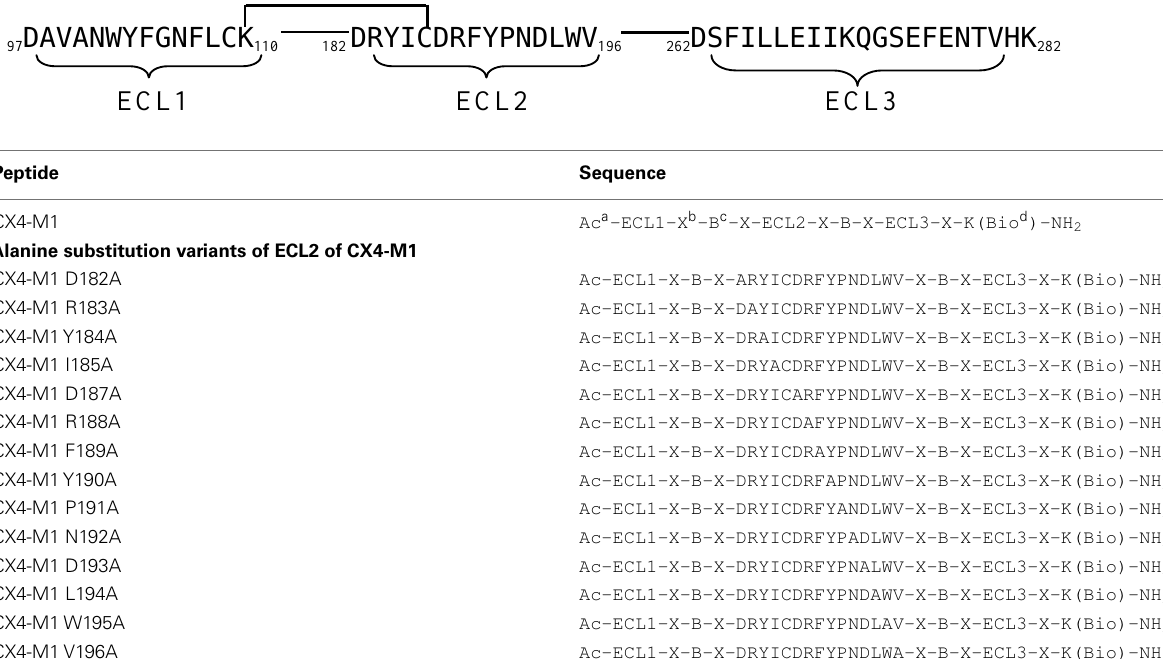
Table 5 |Alanine substitution variants of the CXCR4 mimetic peptide CX4-M1.